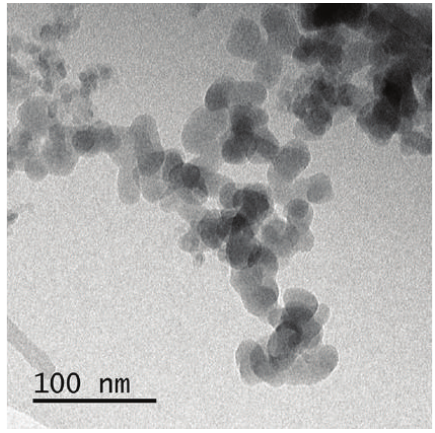
Figure 2: TEM image of NS30. Table 1: Chemical composition of ordinary portland cement and sulphoaluminate cement.